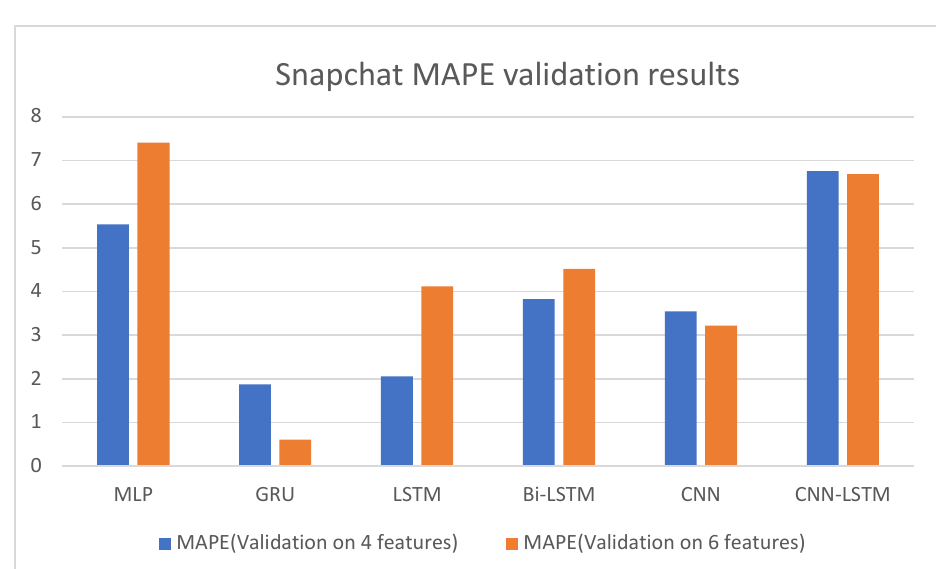
Figure 9. The visualization of the MSE results of Snapchat .